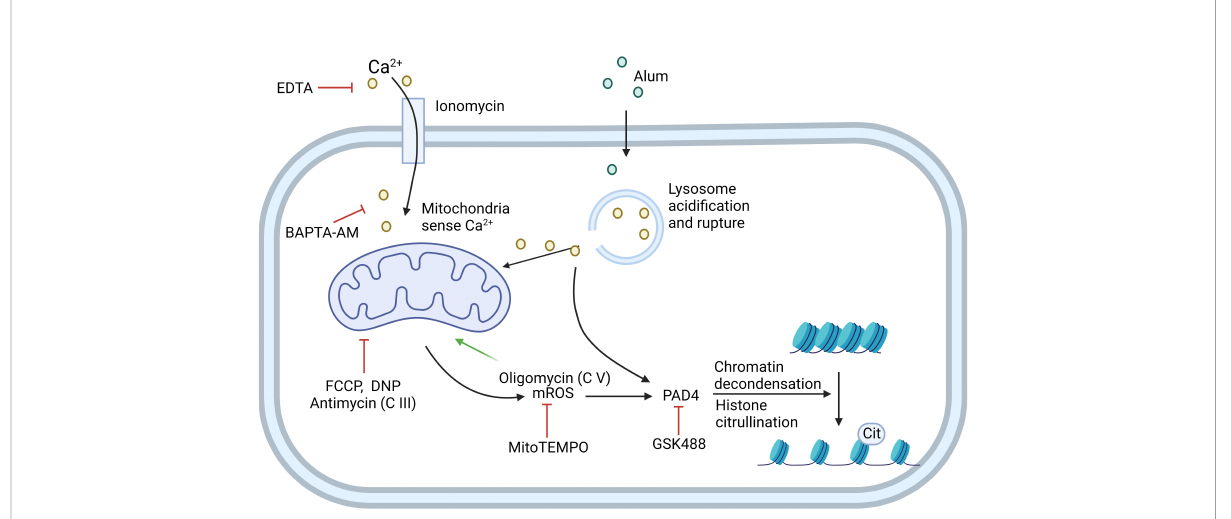
FIGURE 2 NOX-independent NETosis can be induced by ionomycin or alum. Ionomycin works as a Ca 2+ ionophore to transfer extracellular calcium (Ca 2+ ) into cells. Alum causes lysosome acidi fi cation and rupture, which then leads to Ca 2+ release. Mitochondria sense the elevation of Ca 2+ in the cytoplasm and generate mitochondrial ROS (mROS). Cytoplasmic Ca 2+ and mROS are both required to activate PAD4, which further induces histone citrullination and chromatin decondensation. EDTA and BAPTA-AM can chelate extracellular and cytoplasmic Ca 2+ , respectively, to inhibit this process. Mitochondrial inhibitor FCCP, DNP, and mitochondria complex III inhibitor antimycin can inhibit this process. mROS-speci fi c scavenger MitoTEMPO also inhibits the pathway. Mitochondria complex V inhibitor oligomycin inhibits the retrograde proton transport, therefore leading to the increased MMP which drives enhanced NETosis. GSK488 is an inhibitor of PAD4. C III: complex III; C V: complex V. Created in